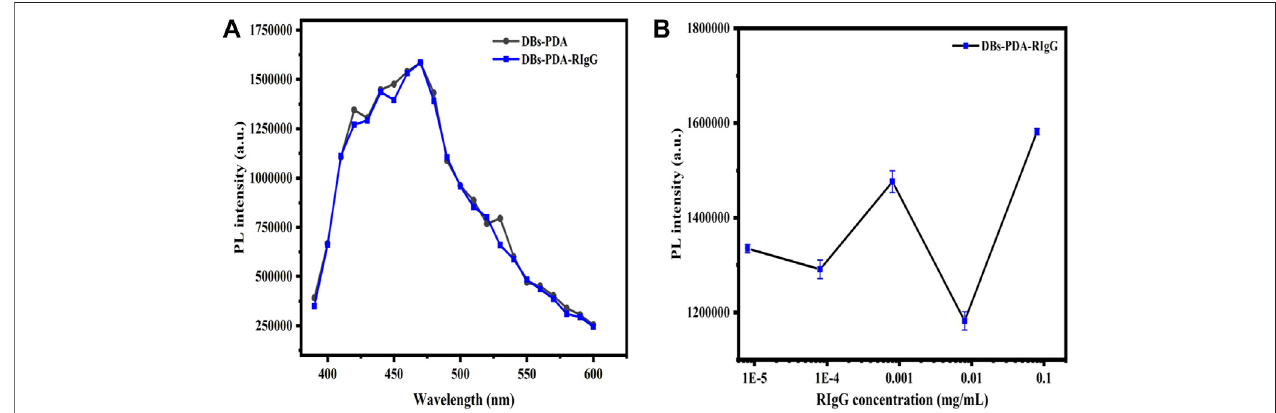
FIGURE 7 | (A) PL spectra of DBs-PDA and DBs-PDA-RIgG. (B) PL spectra showed DBs-PDA binding to different concentrations of RIgG (from 8 × 10 − 9 to 8 × 10 − 2 mg/ml). Excitation wavelength was 360 nm.